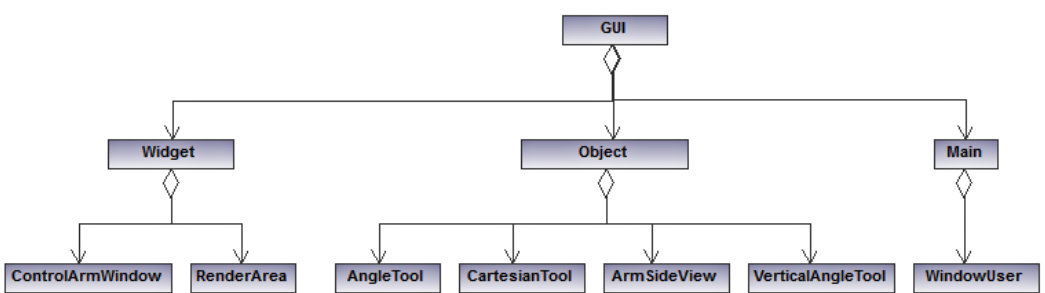
Figure 13. UML class diagram of Graphical User